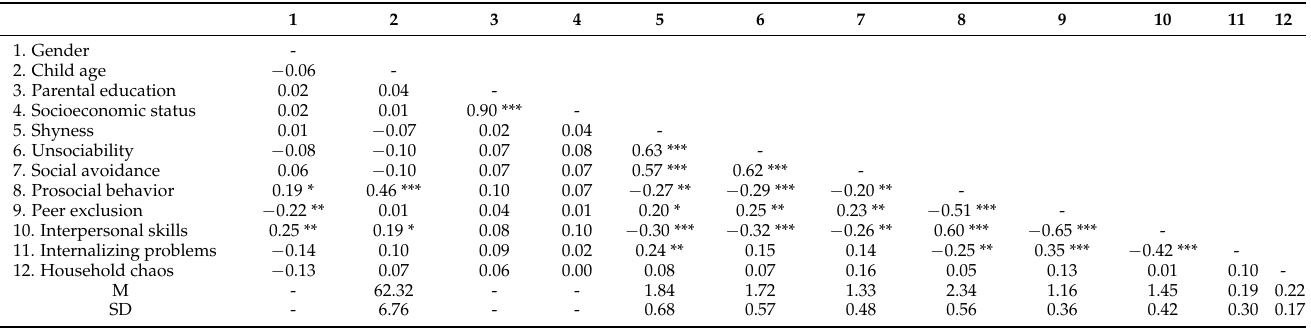
Table 1. Descriptive statistics and inter-correlations for all study variables ( n = 148).